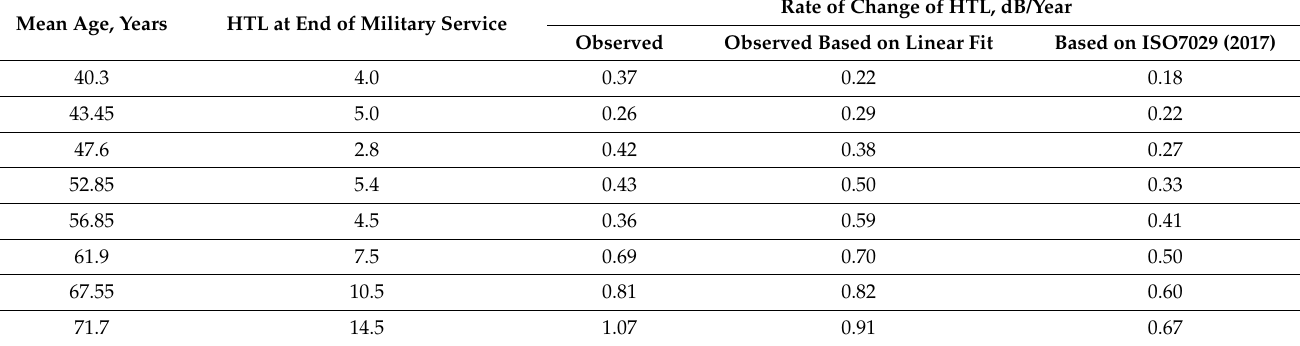
Table 2. Data for the left ear at 1 kHz for each age group of Macrae [5]. The columns show, from left to right: the mean age of the group, the mean initial HTL at 1 kHz for the left ear for each group, the observed rate of change of HTL for that group, the observed rate of change based on a linear fit to the data across groups; and the rate of change expected for non-noise exposed males of the same mean age based on ISO 7029 [4].